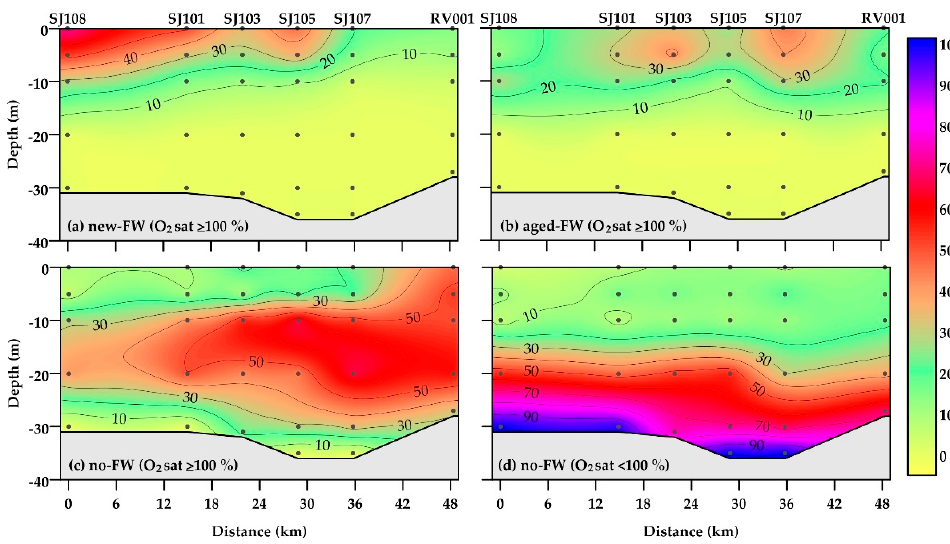
Figure 5. Frequency of occurrence (%) of water types (new ‐ FW, aged ‐ FW, and no ‐ FW waters) in oxygen ‐ saturated ( a, b, c ) and ‐ undersaturated ( d ) conditions in the Northern Adriatic during ters) in oxygen-saturated ( a – c ) and -undersaturated ( d ) conditions in the Northern Adriatic 2004–2013. during